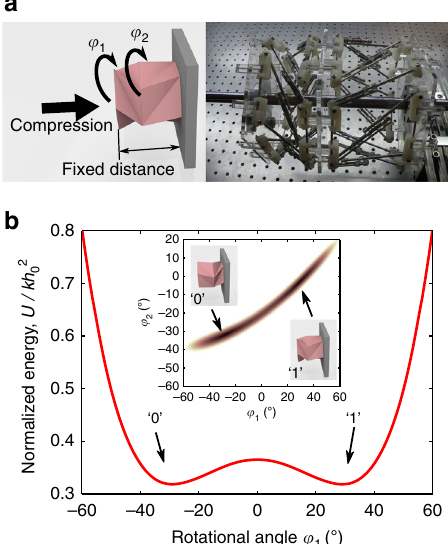
Fig. 3 A pair of TCO cells ’ capability to demonstrate mechanical memory storage. a Two monostable TCO-based unit cells are connected horizontally. We fi x the distance between leftmost and rightmost polygons by imposing a constant distance between them. Photograph of the corresponding con fi guration is shown in the right panel. b The normalized elastic energy as a function of φ 1 shows the double-well potential numerically. The inset shows the surface map of the elastic energy as a function of both φ 1 and φ 2 , where the highlighted region denotes the valley of the map corresponding to the minimum potential energy trajectory. There exist two minimum states, and the illustrations show the schematic shapes of the pair of TCO cells at these points. Here, the con fi guration of the folded right cell represents ‘ 0 ’ , while the one with the folded left cell denotes ‘ 1